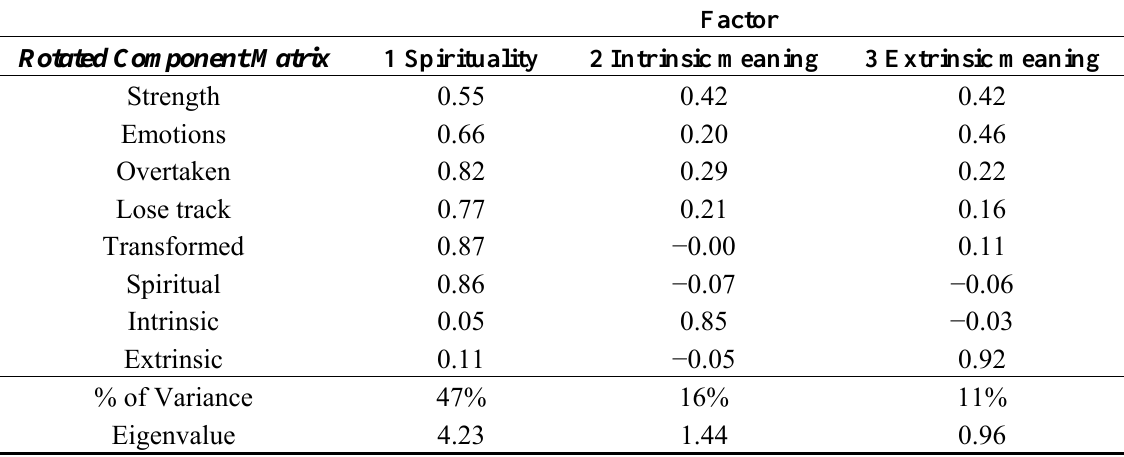
Table 3. Factor analysis of the non-religious context.